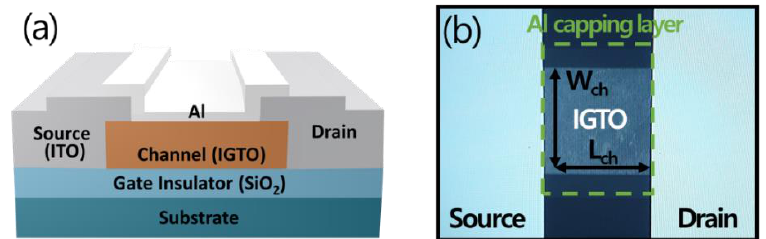
Figure 1. ( a ) Schematic view and ( b ) optical image of the fabricated Al-capped indium–gallium–tin